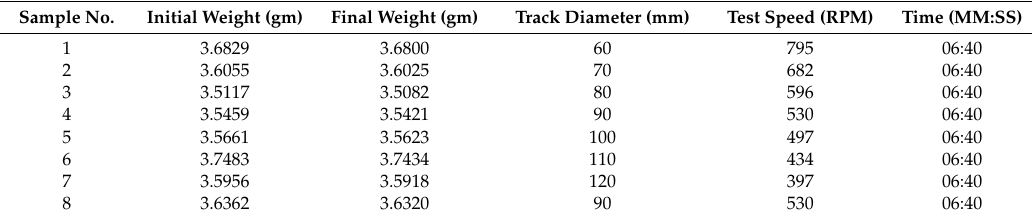
Table A2. Wear loss of samples (Sliding Velocity: 2.5 m/s, Load: 30 N, Sliding Distance: 1000 m). Sample No.